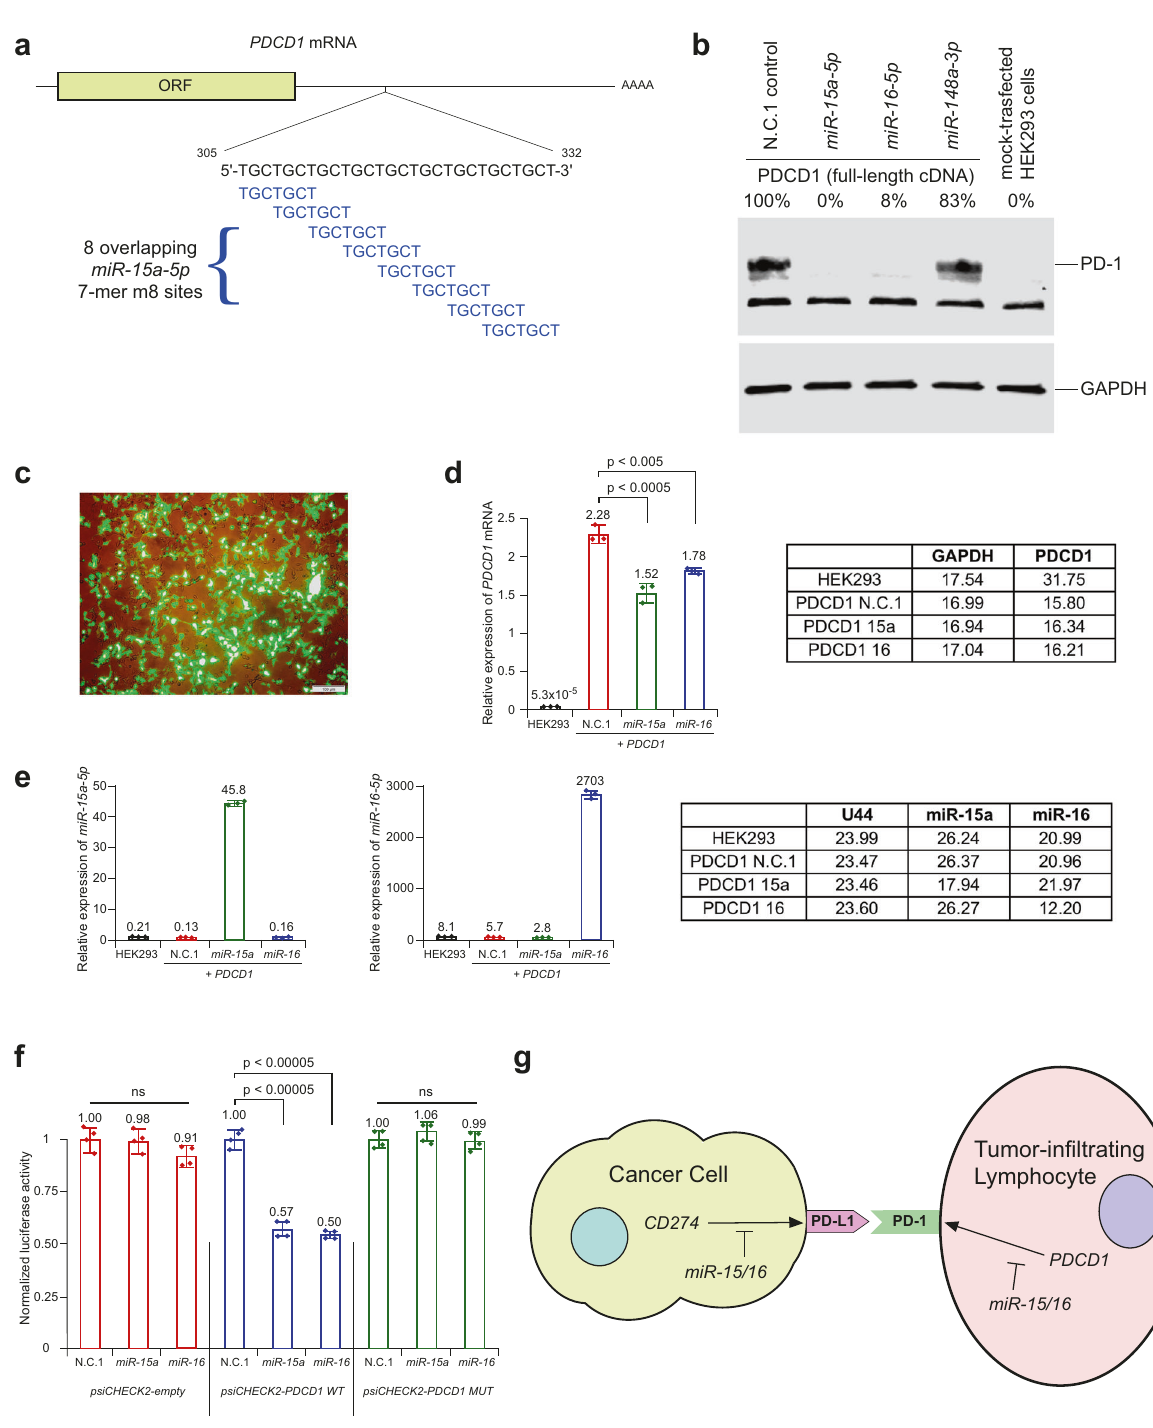
Fig. 1 miR-15/16 target PDCD1 (PD-1) expression. a A 28bp DNA fragment containing eight overlapping miR-15/16 target sites in the 3 ′ UTR of PDCD1 . b miR-15/16 inhibit PD-1 protein expression. miR-15a-5p and miR-16-5p expression suppress the PDCD1 expression by targeting its 3 ’ -UTR. Western blot data showed the protein level of overexpressed PDCD1 in HEK293 cells co-transfected with scrambled pre-miR negative control, pre- mir-15a-5p , pre-miR-16-5p and pre-miR-148a-3p mimics. GAPDH served as a loading control. c An example of transformation ef fi ciency in experiments in HEK293 cells for western blot and Luciferase assays (as shown in b , f ). d , e Results of real-time PCR experiments on RNAs isolated from HEK293 cells co-transfected with PDCD1 construct and miR mimics (same as in b ). d Results of real-time PCR using TaqMan probe for human PDCD1 transcript. Average CT numbers are shown (right). e Results of real-time PCR using TaqMan probes for human miR-15a-5p (left) and miR-16- 5p (middle). Average CT numbers are shown (right). f PDCD1 is a direct target of miR-15/16 . Renilla luciferase reporter assay showing the reporter expression in HEK293 cells co-transfected with wild-type 3 ′ -UTR of PDCD1 and mutant 3 ′ -UTR of PDCD1 along with scrambled negative control 1, miR-15a and miR-16 mimics. Renilla luciferase activity was normalized to fi re fl y luciferase activity. The normalized luciferase activities in HEK293 cells transfected with different psiCHECK2 constructs and scrambled negative control 1 (pre-miR-N.C.1) were set at 1 and relative luciferase activities of HEK293 cells co-transfected with each psiCHECK2 construct and miR-15a or miR-16 mimics are shown. Two independent experiments were carried out in duplicates and data were presented as mean ± SD. g miR-15/16 are key regulators of PD-1 – PD-L1